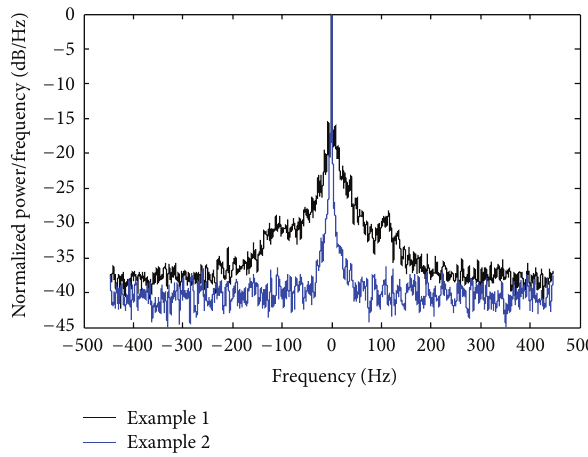
Figure 3: Examples of estimated PSDs corresponding to time variability of the scattering signals as blades rotate.